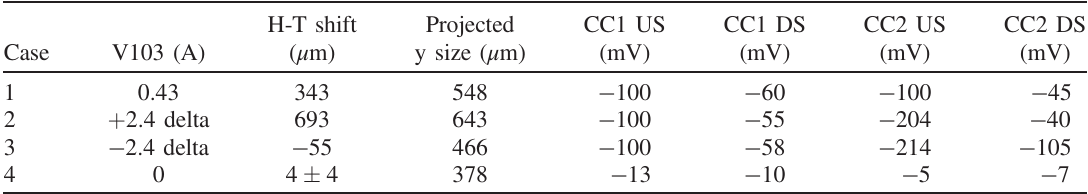
TABLE II. Summary of cases, V103 values, head-tail (H-T) centroid shifts, projected y sizes, and HOM detector signal values. Case 4 is with the HOMs and SRW minimized. The statistical errors for the spatial parameters are < 5% unless provided.